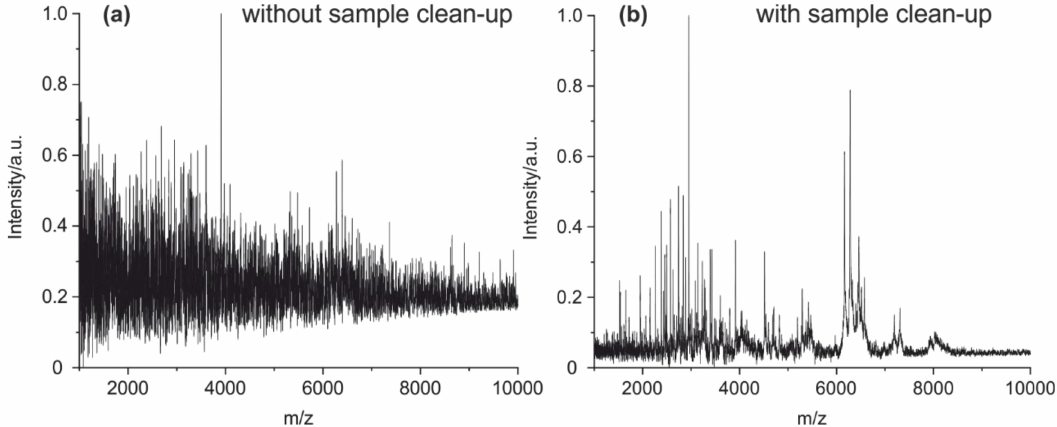
Figure 6. MALDI-TOF MS spectra of a cleavage solution of a mouse IgG1 ( a ) without any treatment and enrichment and ( b ) with clean-up and enrichment on a C18 pipet tip